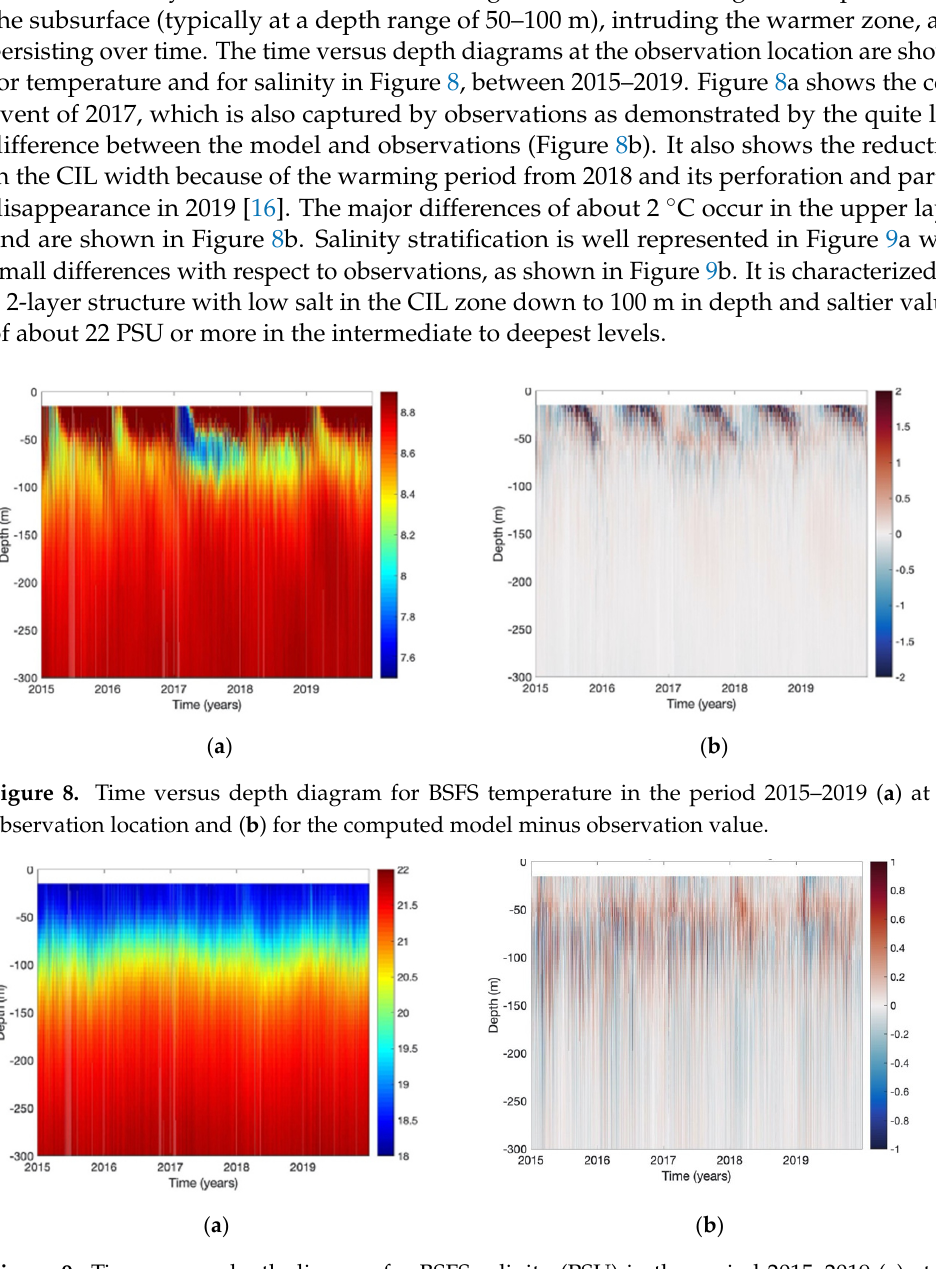
Figure 7. RMS of 𝐴𝐹 (Analysis-Forecast, in blue), 𝑃𝐹 (Forecast-Persistence, in orange) for temper- ature (on the left, ( a1 – a3 ), expressed in °C) and salinity (on the right, ( b1 – b3 ), expressed in PSU) at 2.5 m (1), 30.0 m (2) and 150 m (3), computed for August 2020.